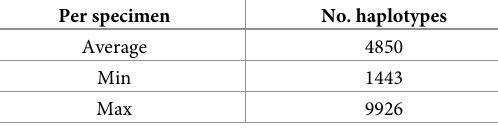
Table 1. Intra-host HCV HVR1 heterogeneity. Per